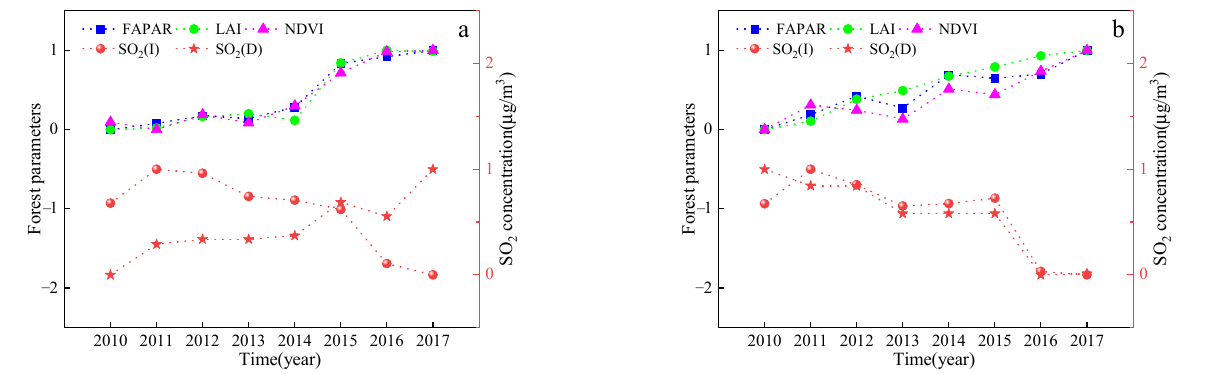
Figure 6. Trends in domestic and industrial SO 2 emissions and vegetation characteristics in 2015–2020 (( a ). Jilin, ( b ). Liaoyuan).